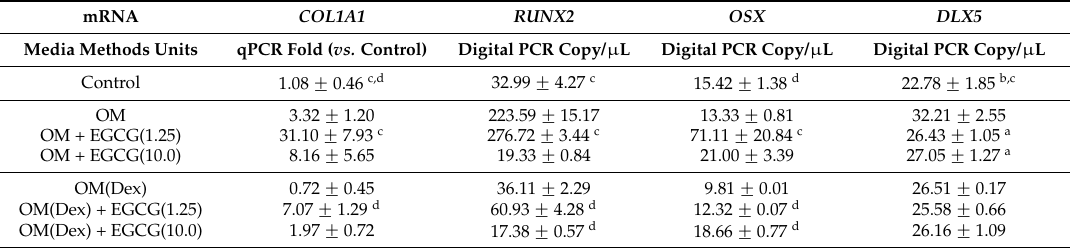
Table 2. mRNA expression levels of osteogenic markers in dedifferentiated fat (DFAT) cells treated with media on day 1. mRNA COL1A1 RUNX2 OSX DLX5 Media Methods Units qPCR Fold ( vs. Control) Digital PCR Copy/ µ